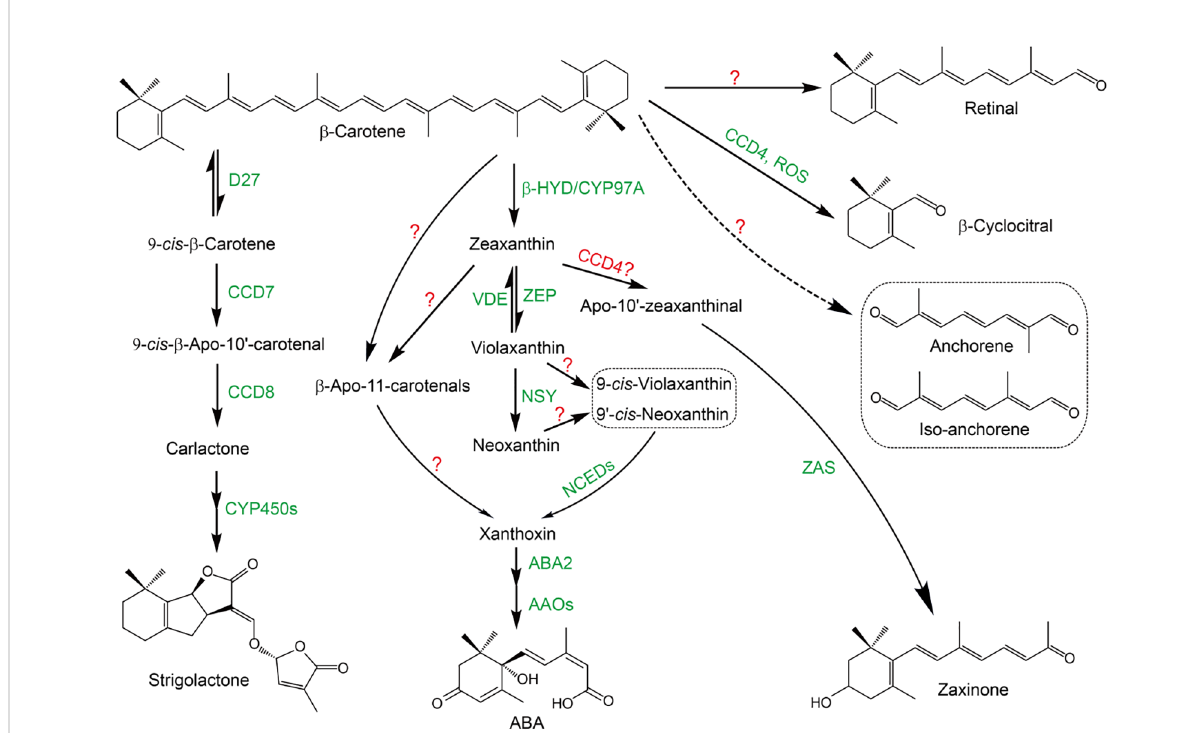
FIGURE 1 The biosynthesis pathway of carotenoid-derived root regulators. The identi fi ed enzymes are marked as green and the presumptive enzyme is marked as red. “ ? ” indicates that the enzymes responsible for the reaction have not been identi fi ed yet. Strigolactone: b -Carotene is fi rst isomerized into 9- cis - b -carotene by dwarf27 (D27) in a reversible manner; 9- cis - b -carotene is sequentially oxidative cleaved by CCD7 and CCD8 to produce the key intermediate carlactone, which is further catalyzed by CYP450s (OsMAX1s) to produce strigolactones. ABA: b - Carotene is hydroxylased by non-heme diiron oxidase (HYD)/CYP97A into zeaxanthin; zeaxanthin and violaxanthin can be interconverted into each other by zeaxanthin epoxidase (ZEP) and violaxanthin de-epoxidase (VDE), respectively; violaxanthin is transformed into neoxanthin by neoxanthin synthase (NSY); violaxanthin and neoxanthin are further isomerized by yet unknown enzymes into 9- cis -violaxanthin and 9 ’ - cis - neoxanthin, respectively, which are further oxidatively cleaved by NCEDs into xanthoxin; xanthoxin is then sequentially catalyzed by aba- de fi cient 2 (ABA2) and abscisic aldehyde oxidases (AAOs) to fi nally produce ABA; recently, an alternative route from b -carotene or zeaxanthin to xanthoxin has been identi fi ed, which uses b -apo-11-carotenals as intermediates, even though the exact enzymes responsible for this route have not been identi fi ed. Zaxinone: ZAS catalyzes the presumptive zeaxanthin oxidative cleavage product, apo-10 ’ -zeaxanthinal to produce zaxinone. b -Cyclocitral can be produced from b -carotene catalyzed by CCD4 or non-enzymatically by ROS. Principally, retinal, anchorene and iso- anchorene could be produced from the oxidative cleavage of b -carotene, however, the experimental evidence is still